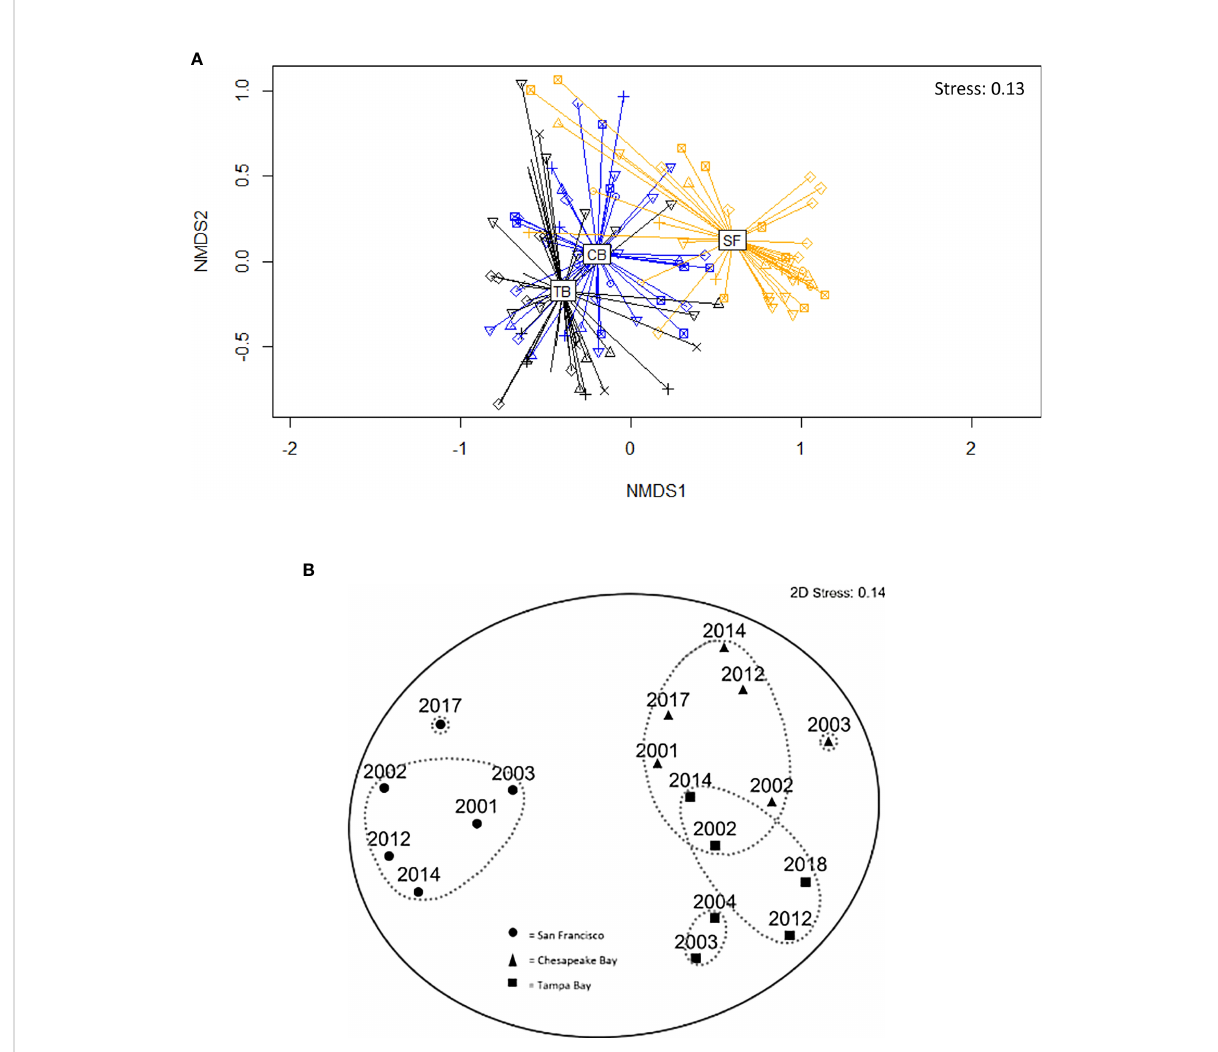
FIGURE 5 Nonmetric multidimensional (nMDS) ordinations of Bray – Curtis distance dissimilarity matrices of 3-month summer panels: (A) Chesapeake Bay (blue), San Francisco Bay (yellow), and Tampa Bay (black) with shapes representing different years of sampling effort and each point representing one site (using R). (B) Chesapeake Bay (triangles), San Francisco Bay (circles), and Tampa Bay (squares), with each point representing 1 year integrated across sites and contours indicating levels of similarity between bays (dashed-gray line, 80%; solid line gray, 60%) (using